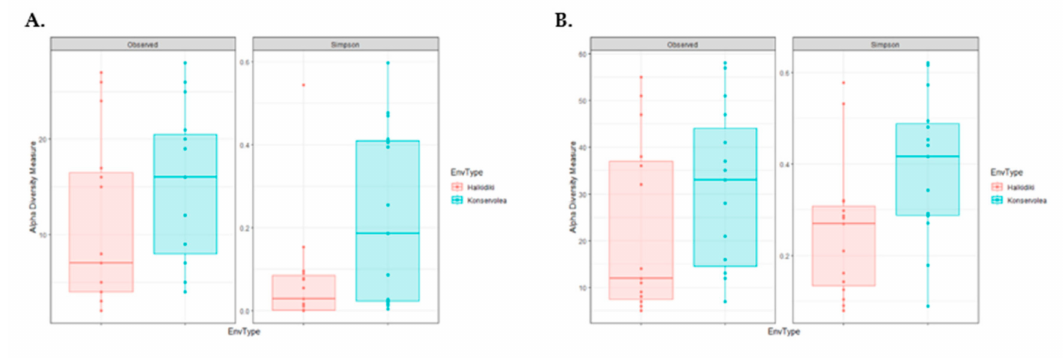
Figure 5. Alpha-diversity boxplots for table olives yeasts families ( A ) and species ( B ) of cultivar Halkidiki and Konservolia based on observed and Simpson indices.